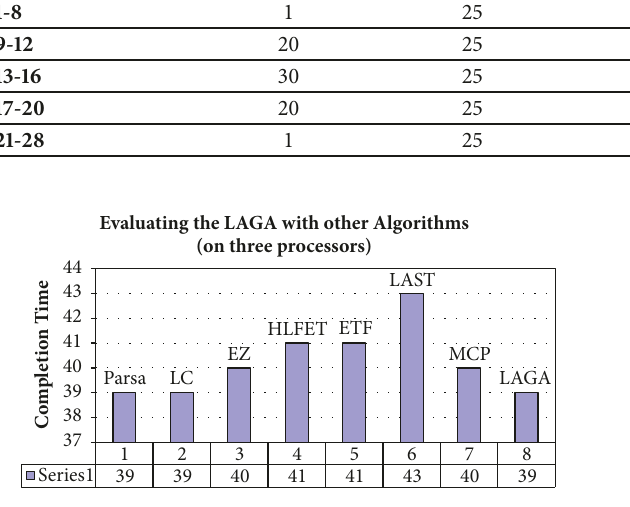
Figure 9: Comparison of the completion times on task graph Figure 6.